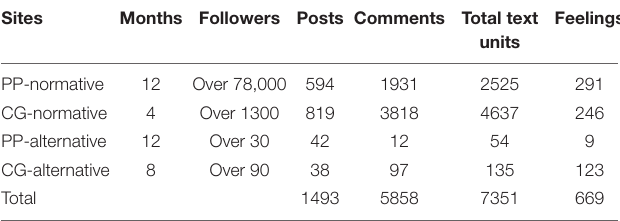
TABLE 1 | Facebook sample